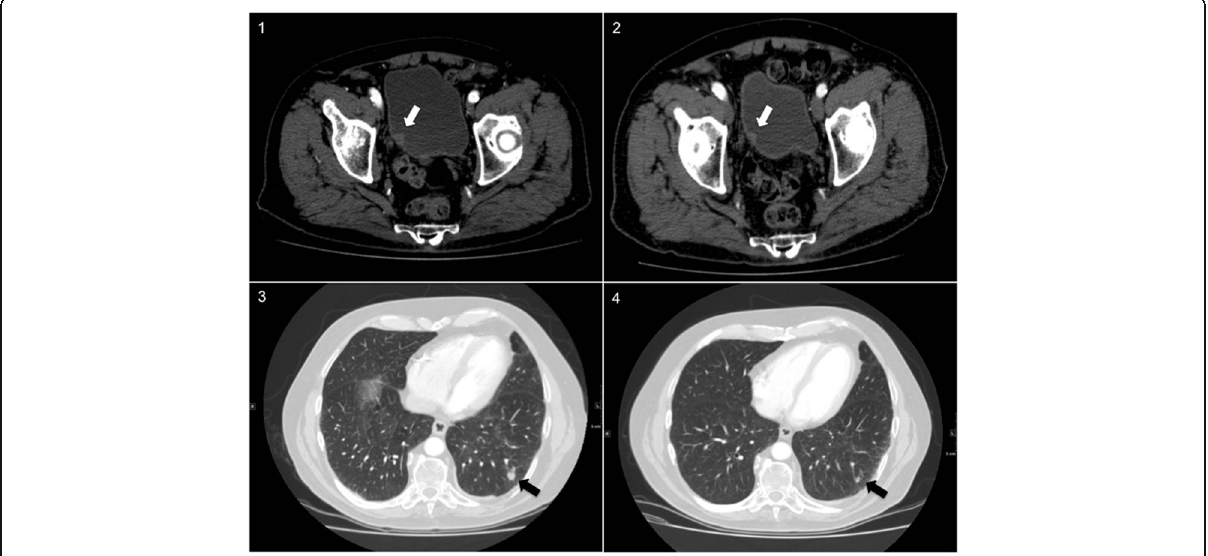
Fig. 1 Example images of missed malignant findings on surveillance CT Angiogram post endovascular aortic aneurysm repair. Axial slice of CTA showing the urinary bladder right lateral wall thickening (white arrow), confirmed bladder transitional cell carcinoma at diagnosis ( 1 ) and retrospectively on a previous scan ( 2 ). Axial slice of CTA showing the 11 mm left lung lower lobe lesion (black arrow), confirmed adeno- squamous lung cancer at diagnosis ( 3 ) and retrospectively on a previous scan ( 4 ), which was initially considered benign